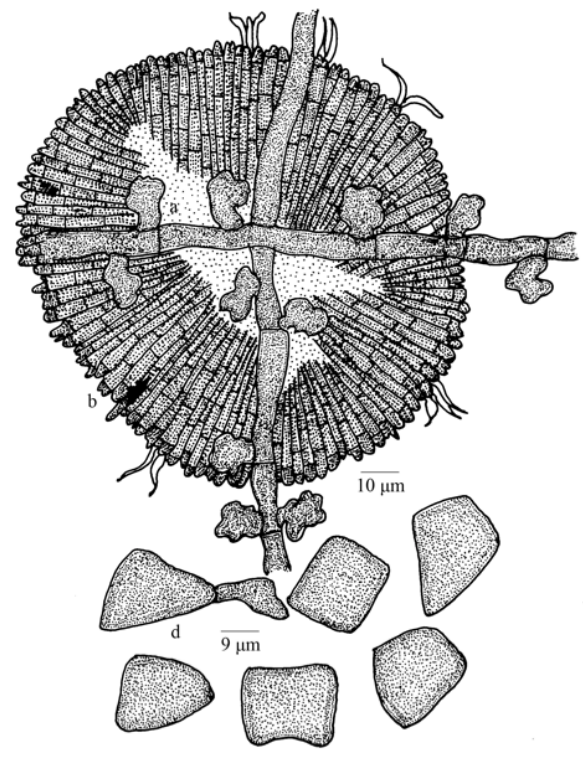
Figure 180. Mahanteshamyces agrostachydis a - Appressoriate mycelium; b - Pycnothyrium; c -